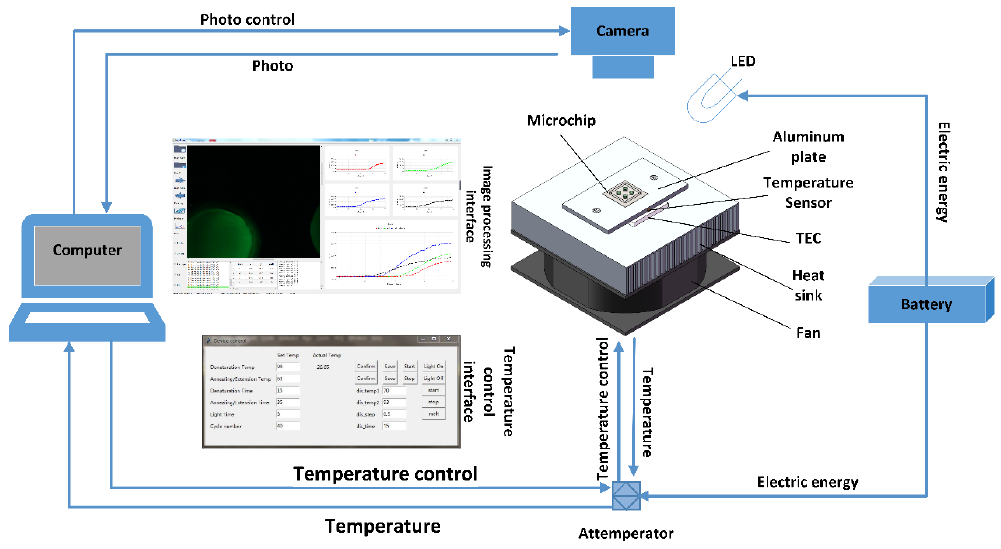
Figure 1. Overview of the fluorescent PCR system. The system is powered by lithium batteries. The temperature cycle of the thermoelectric cooler (TEC) is controlled by a computer. The fluorescence information is collected by a camera. Then, the computer processes the collected information and draws a curve.